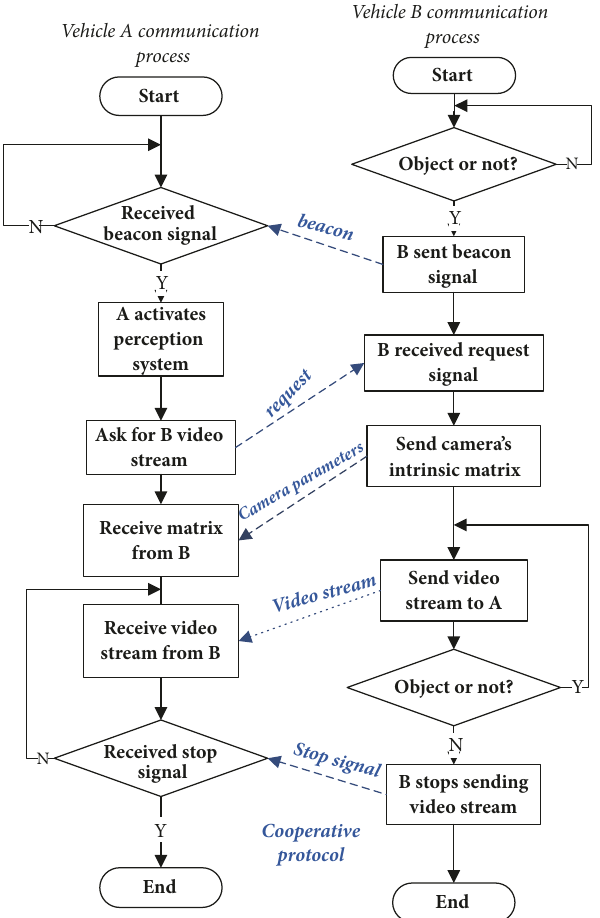
Figure 3: Flowchart showing the communication protocol between two vehicles and processing flow of each